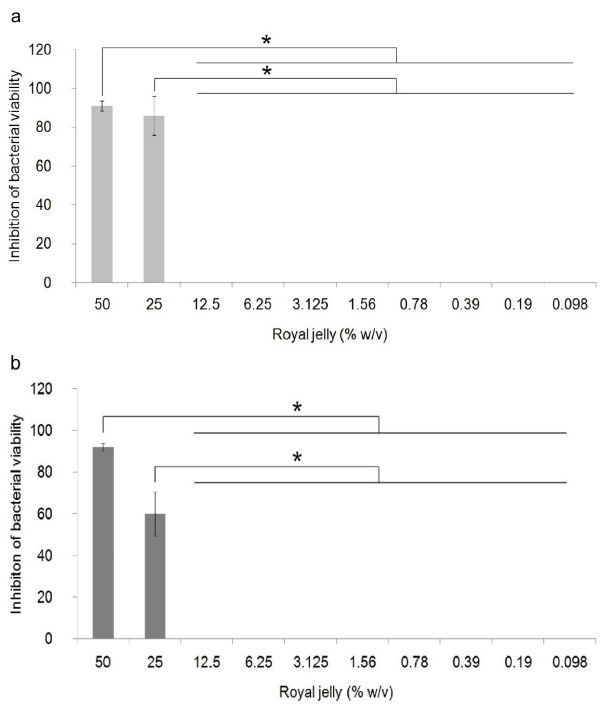
Figure 1. Percentage of inhibition of growth of P. aeruginosa bacteria (1.5 × 10 5 CFU/well). Bacterial cultures were incubated with varying concentrations of royal jelly for 18 hours at 37°C. Royal jelly 50% and 25% inhibit bacterial growth. The difference is based on the results of the Games-Howell analysis at the significance value (*) p <0.05. ATCC 10145 ( a ) strain; clinical isolate ( b